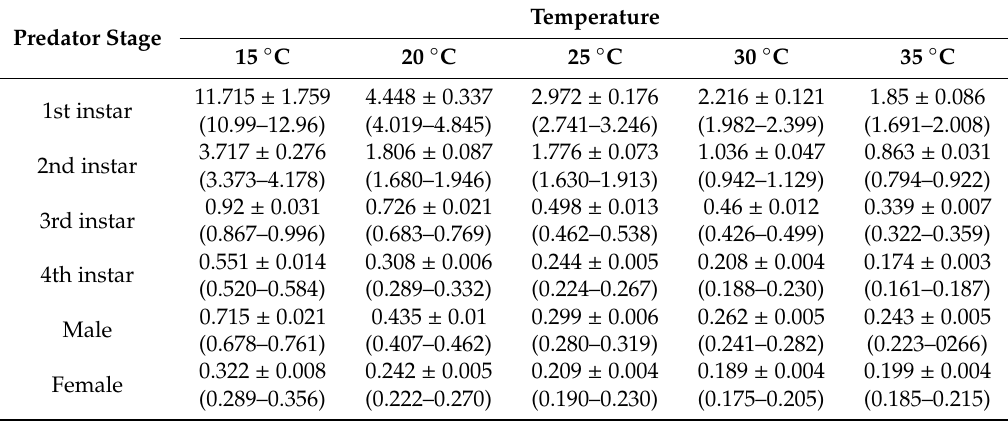
Table 5. Coe ffi cients of handling time (mean ± SE) of Harmonia axyridis at various predatory stages and temperatures, preying upon Spodoptera litura eggs (according to Rogers’ random predator equation).